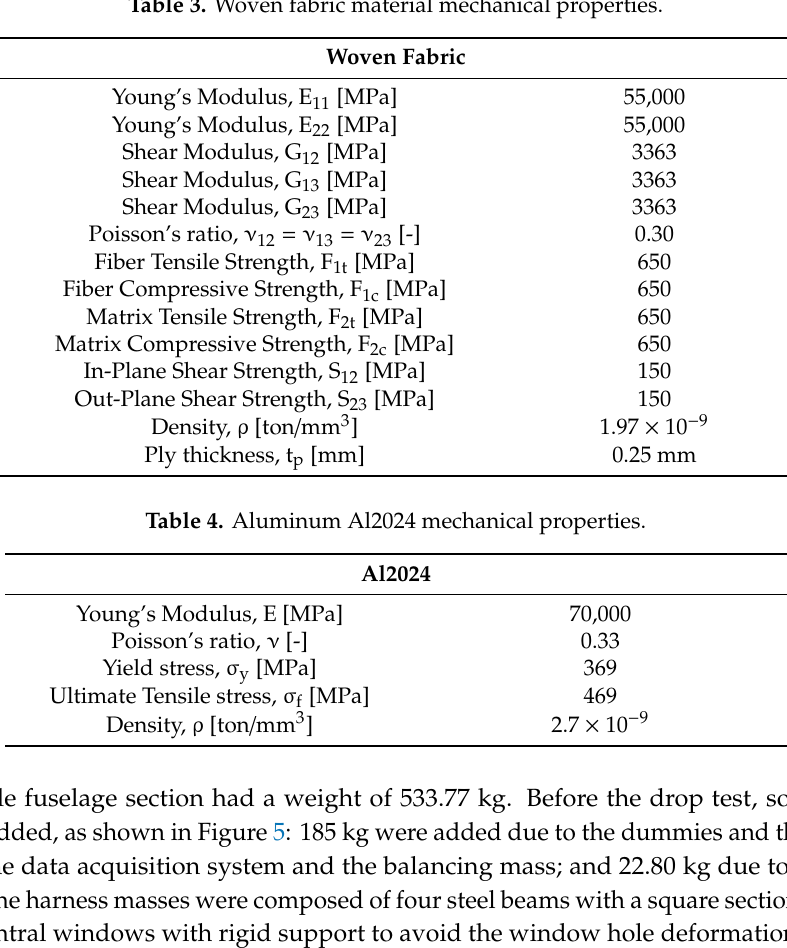
Table 3. Woven fabric material mechanical properties.